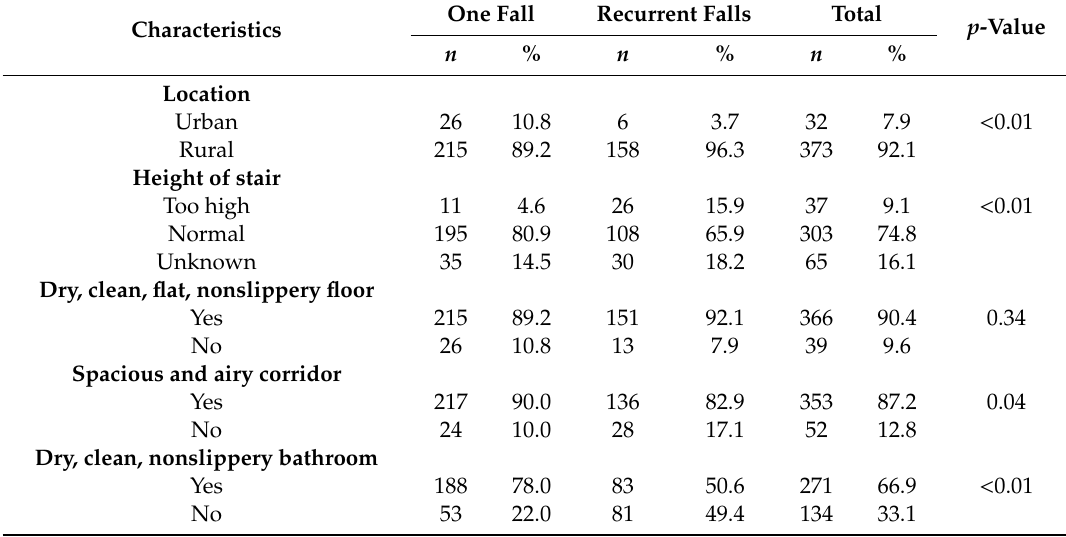
Table 3. Prevalence of recurrent falls according to environmental